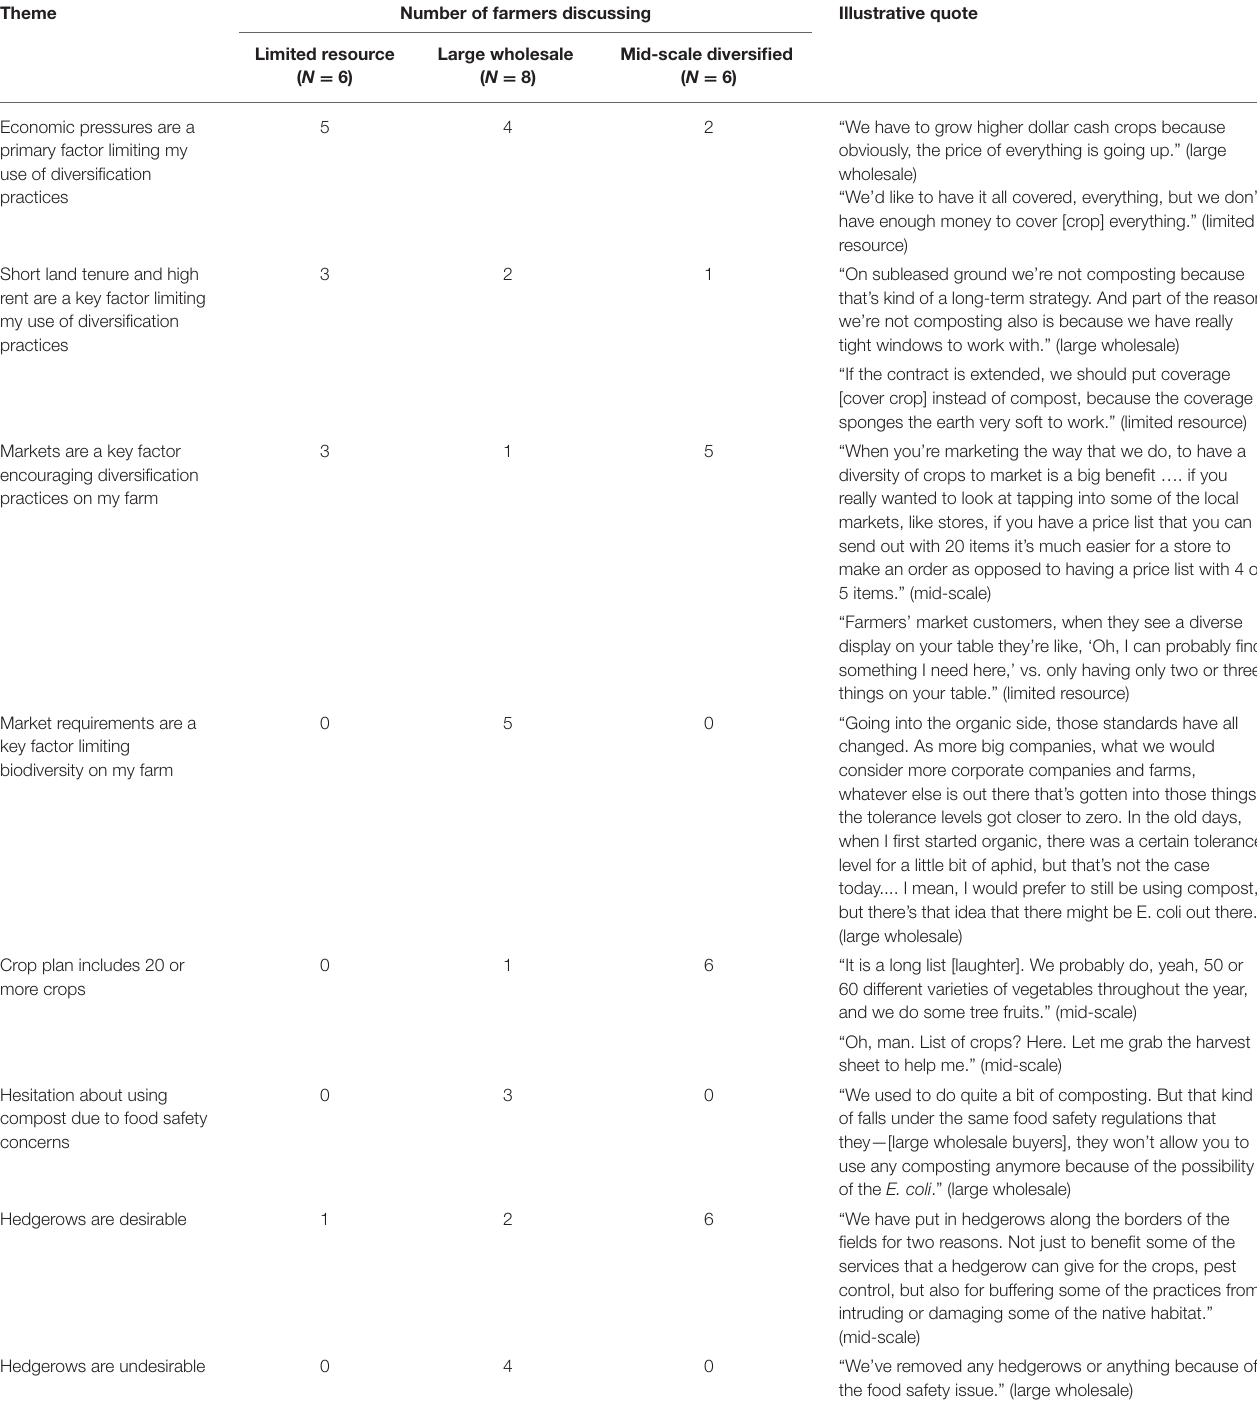
TABLE 3 | Key themes in the perception and implementation of diversification